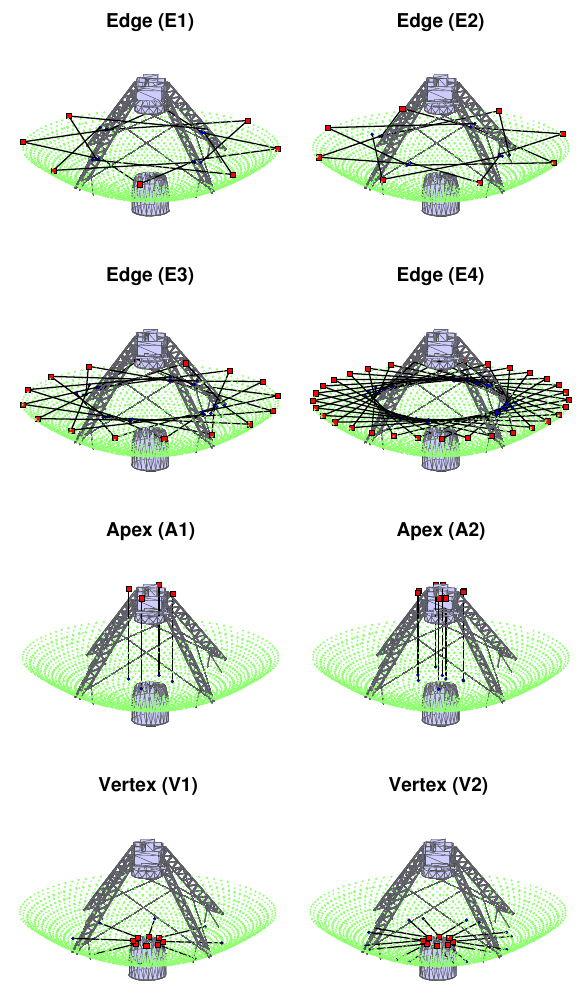
Figure 3: Fundamental sets of cameras: the red squares corre- spond to the cameras, and the black lines to the optical axes; tar- gets are represented by the green